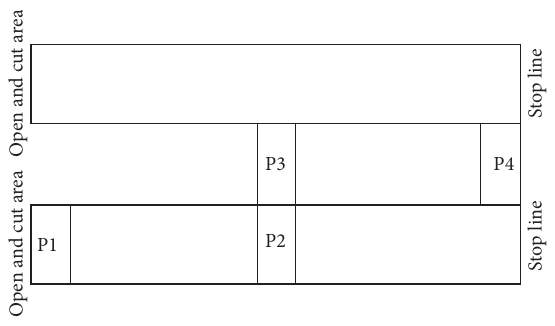
Figure 8: Building load location.